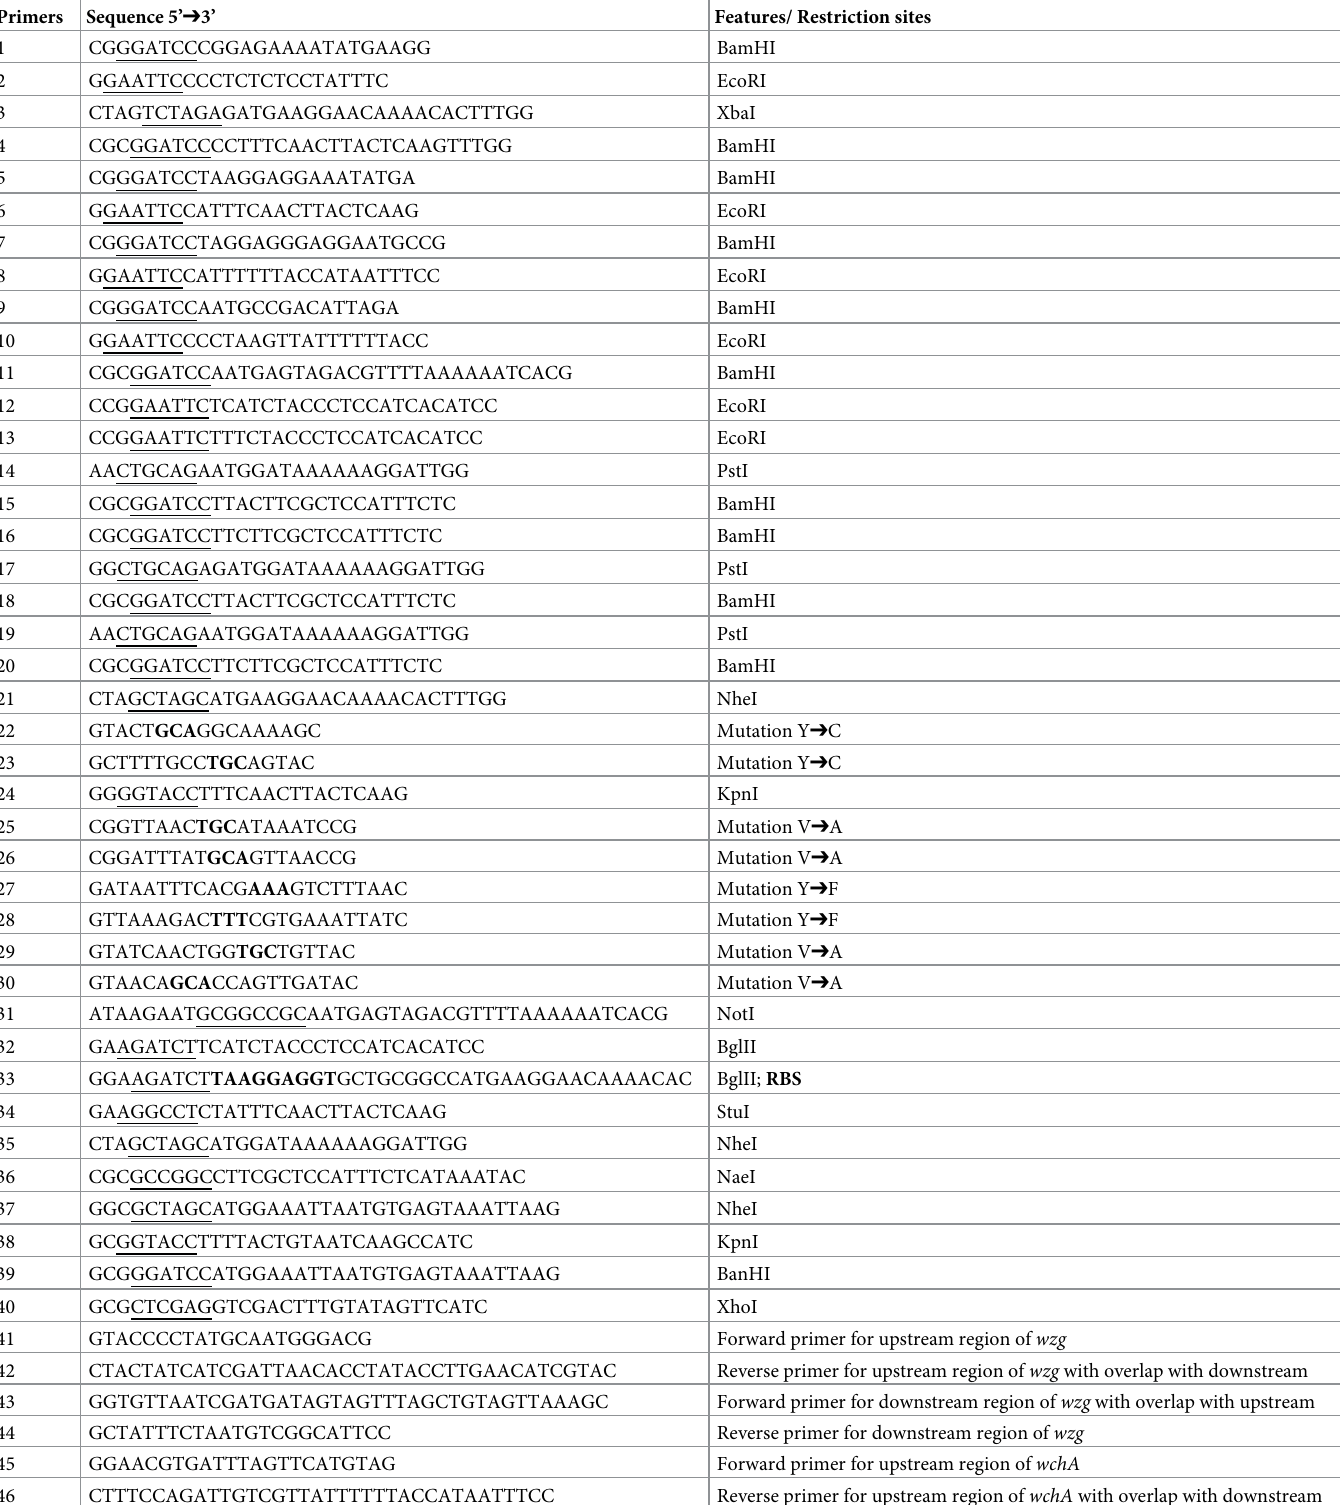
Table 2. Primers used in this